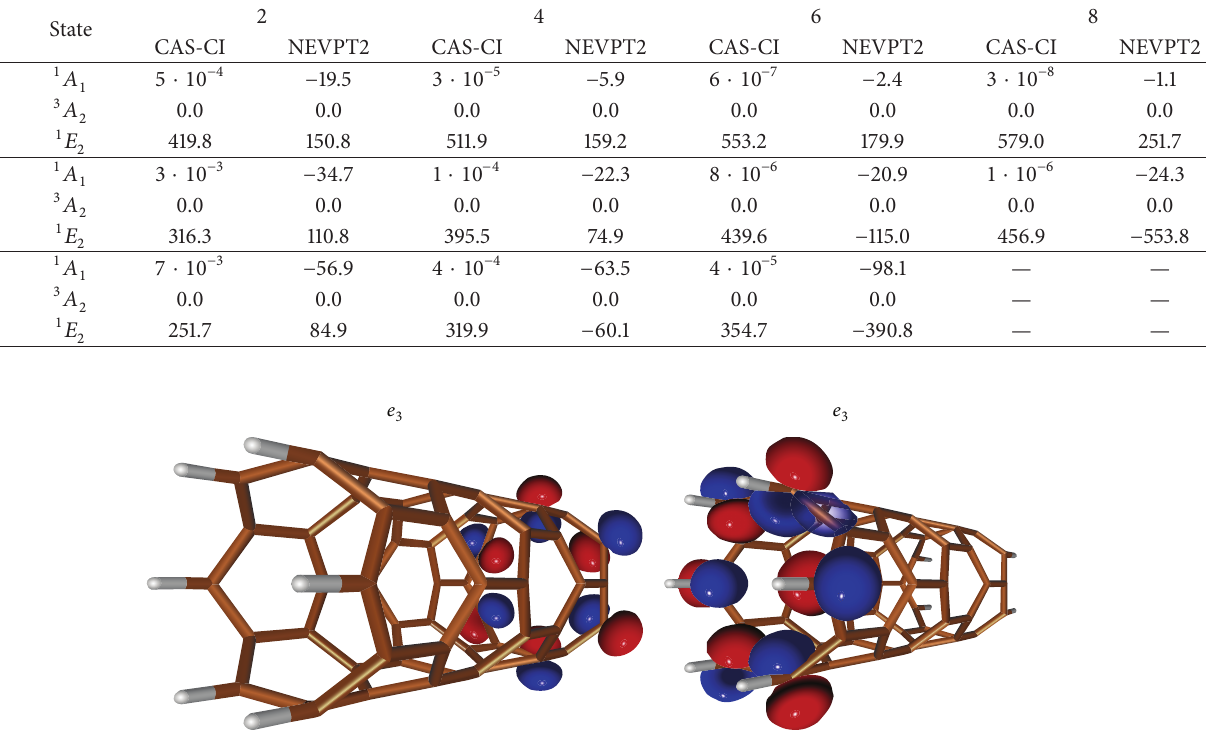
Figure 6: Active orbitals of nanotube (6 4) as an example of nanotubes with both 𝑛 and 𝑝 even. The orbitals are of identical size; the apparent difference in size is due to the perspective.